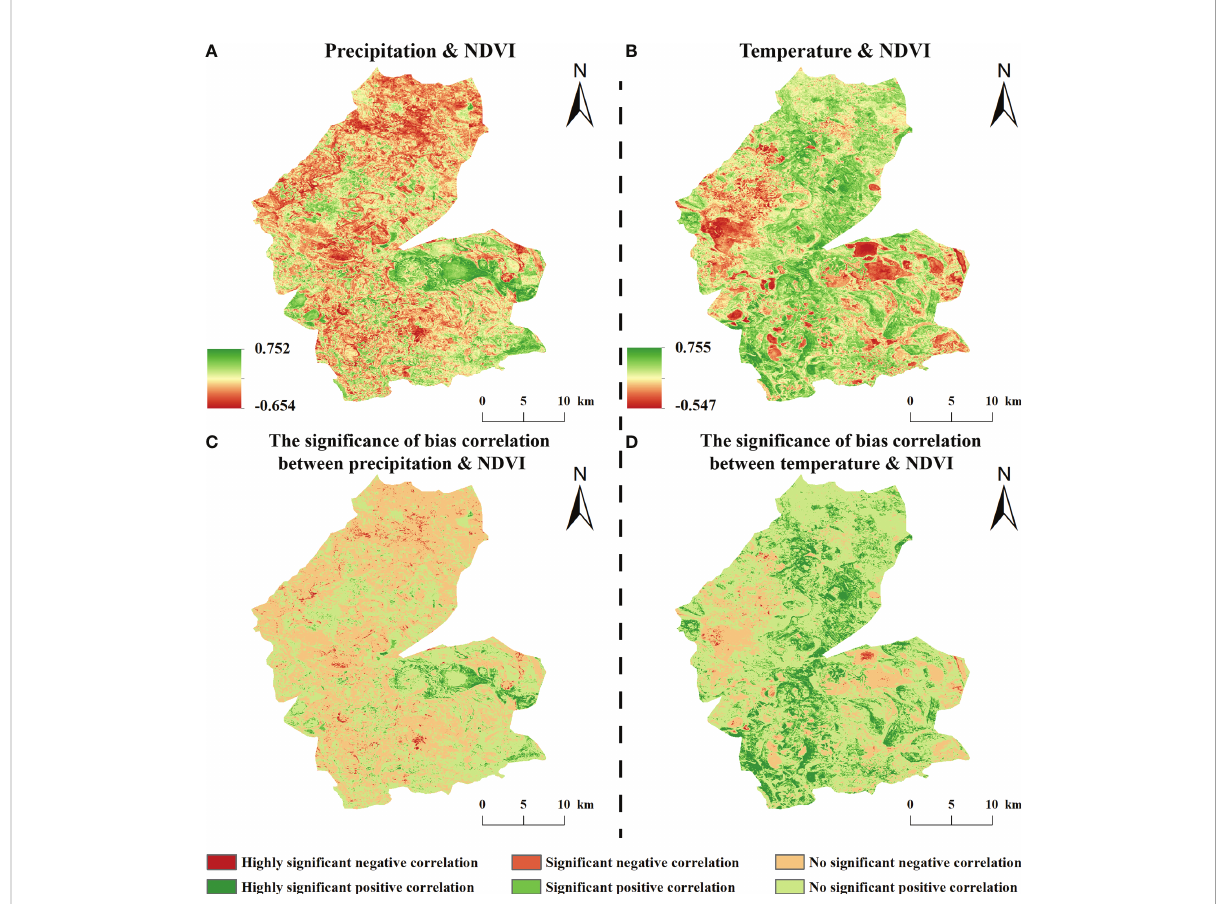
FIGURE 6 Bias correlation between NDVI and climatic factors from 1984-2020 ( A, B are the bias off NDVI with precipitation and temperature, respectively; C, D are the respective signi fi